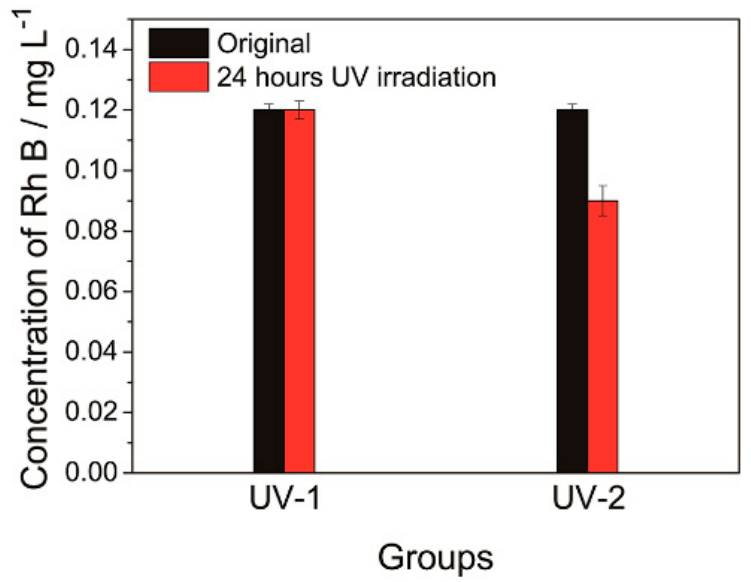
Figure 14. UV degradation test of rhodamine B (Rh B): Changes in Rh B concentration of UV-1 and UV-2 after UV irradiation.